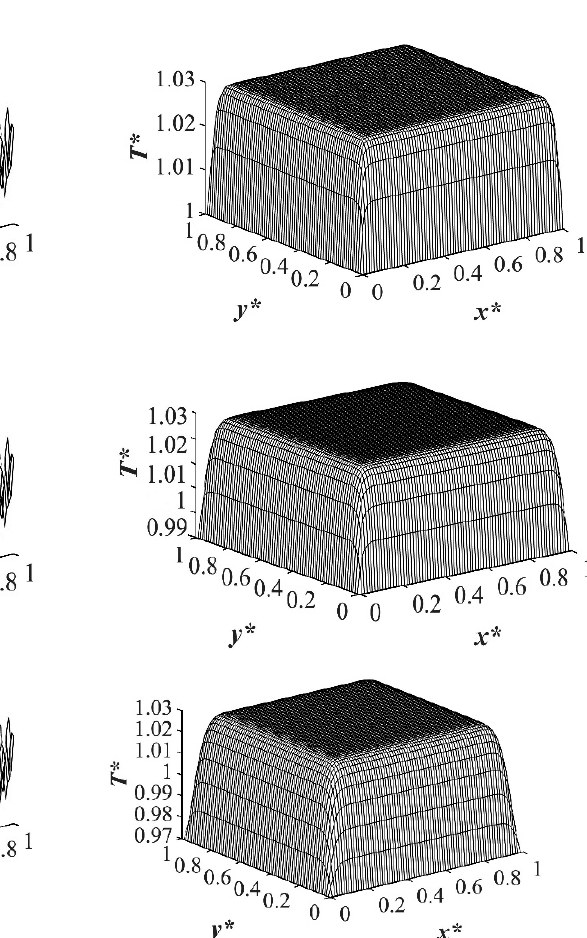
Figure 7. Spatial concentration ( left column) and temperature ( right column) profiles for the off- critical quench to c * = 0.909 at t * = 2.03 × 10 − 5 for three different quench depths of ( a ) T * q1 = 1.0, ( b ) T * q2 = 0.99 ( c ) T * q3 = 0.97.